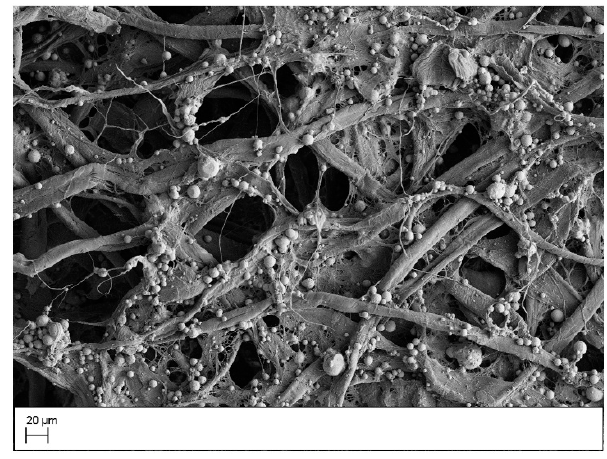
Figure 1. A scanning electron microscope image of a Zinculose strip at 500×.